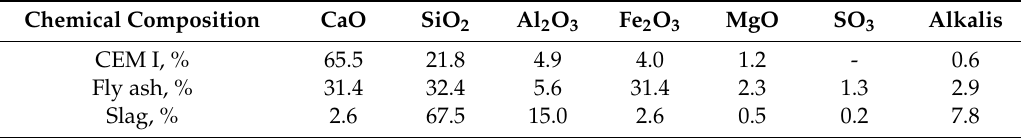
Table 3. Technical characteristics of the micro-reinforcing fibers.